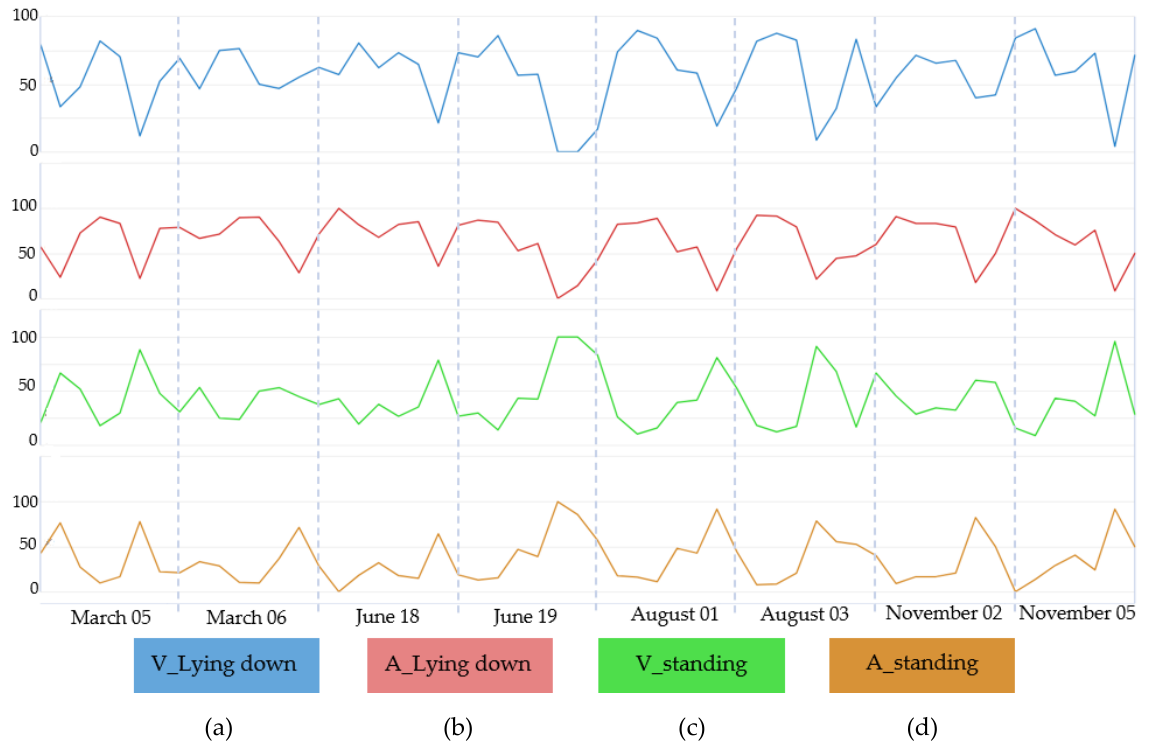
Figure 5. Time series of cow behavior over 1 year, with analysis performed visually (V) lying down ( a ), visually standing up ( c ), by the algorithm (A), lying down ( b ), and by the algorithm standing up ( d ). Visually comparing the format and trend of the graph lines, there is a similarity between the two types of analysis used (visual and algorithm), demonstrating that the tool used tends to be effective in its use for animal behavior